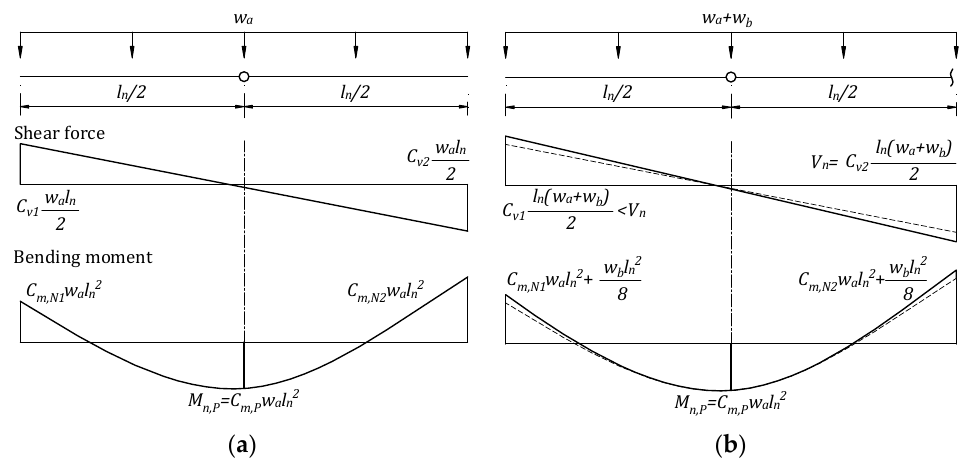
Figure A6. Failure mechanism for DB-3a region. ( a ) Flexural failure at the mid-span section first and then ( b ) shear failure at the N2 section.